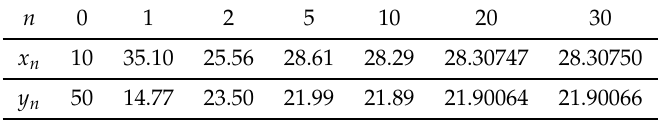
Table 8. Values of the iterated sequence ( x n , y n ) if started with ( 10,50 ) .